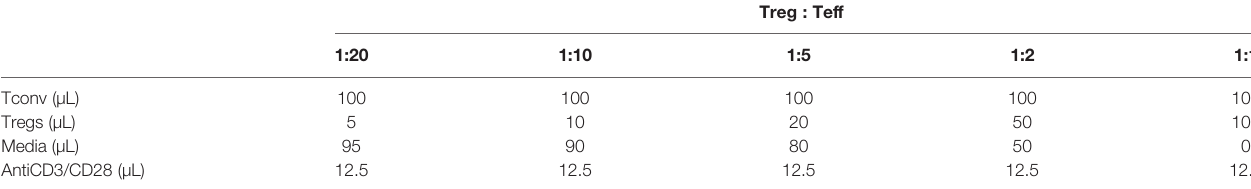
TABLE 2 | Suppression